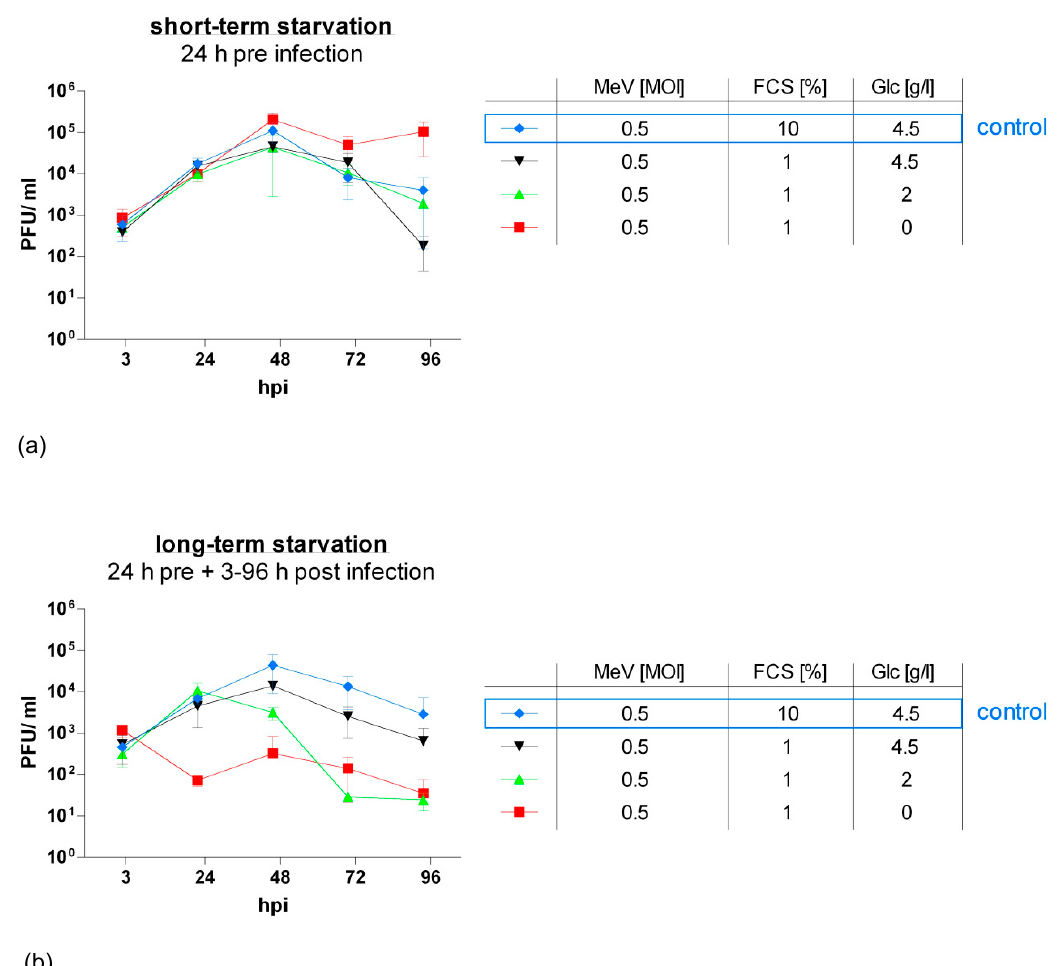
Figure 5. Viral replication under short-term ( a ) or long-term low-serum ( b ) starvation in HT-29 cells. After seeding on day 0, HT-29 cells underwent starvation either for 24 h pre-infection (( a ): short-term starvation; Figure 1a) or for both 24 h pre- and 3–96 h post-infection (( b ): long-term starvation; Figure 1b). Infection with MeV (MOI 0.5) was performed on day 2. Supernatants and tumor cell lysates were harvested at 3, 24, 48, 72, and 96 hpi. Titrations were performed on Vero cells and calculated as total amount of plaque-forming units (PFU) / mL (comprising PFU in supernatants plus cell lysates); control: tumor cell cultures and infections performed under standard medium conditions (no starvation). Means and SD of three independent experiments are